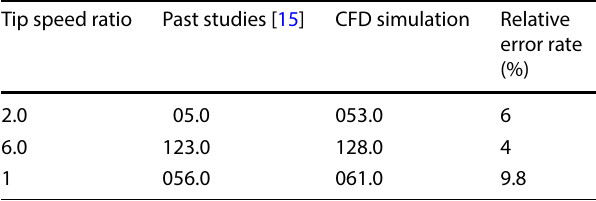
Table 4 Comparison of production power coefficient between sim- ulation results and past studies at 8